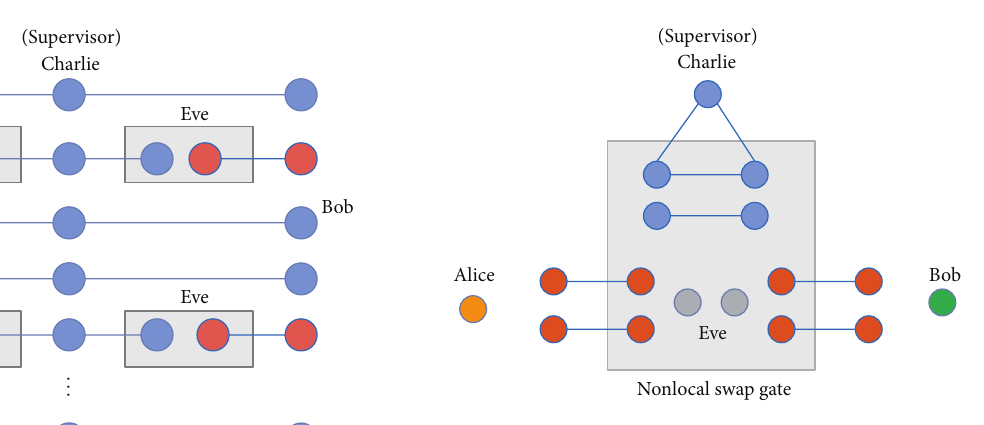
Figure 7: The scenario of Eve steals secret message by the nonlocal swap gate